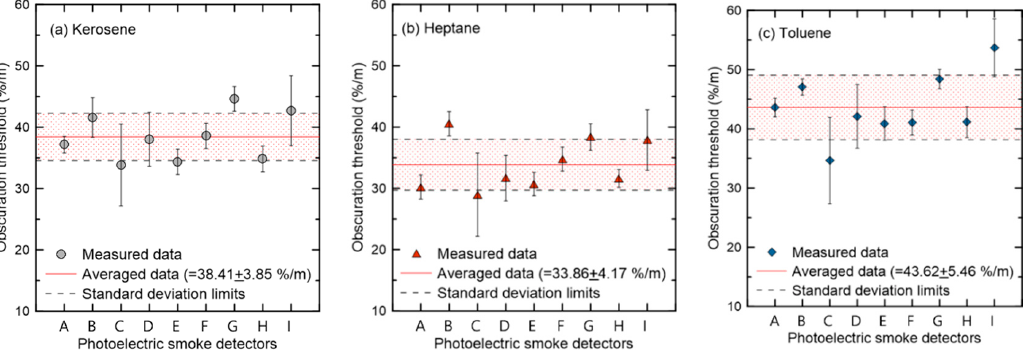
Figure 8. Comparison of obscuration thresholds with liquid fuels (( a ) kerosene, ( b ) heptane and ( c ) toluene) for various models of the photoelectric detector (A~I).